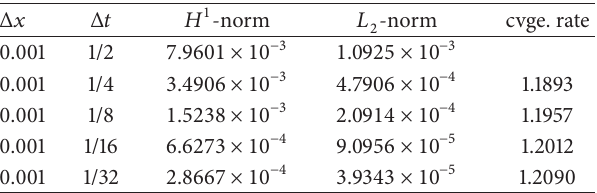
Table 1: Convergence rate in time for Example 3.